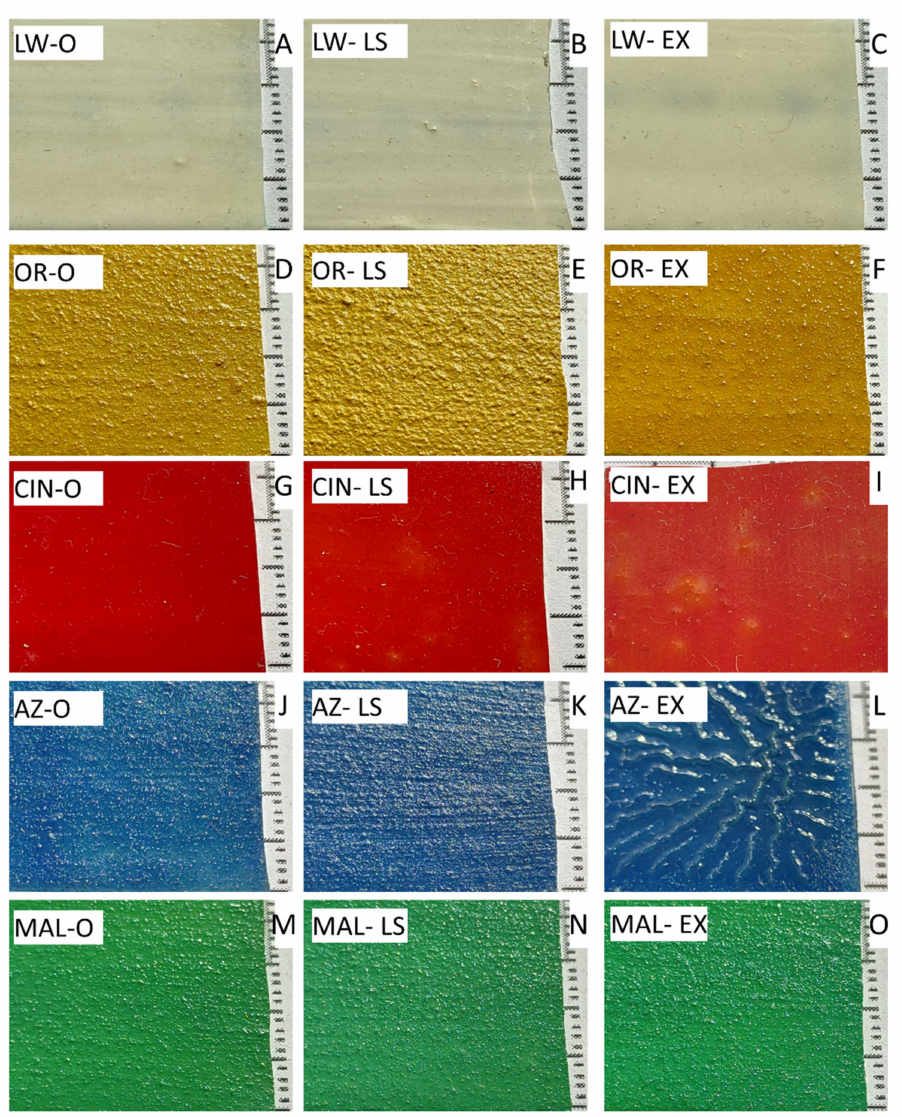
Figure 6. Digital photographs of the painting mock-ups used to determine the influence of the binder quantity (O-optimal quantity-, LS-low binder- and EX-excess binder-) on the reflectance. ( A – C ): lead white (LW)-based oil painting mock-ups. ( D – F ): orpiment (OR)-based oil painting mock- ups. ( G – I ): cinnabar (CIN)-based oil painting mock-ups. ( J – L ): azurite (AZ)-based oil painting mock-ups. ( M – O ): malachite (MAL)-based oil painting